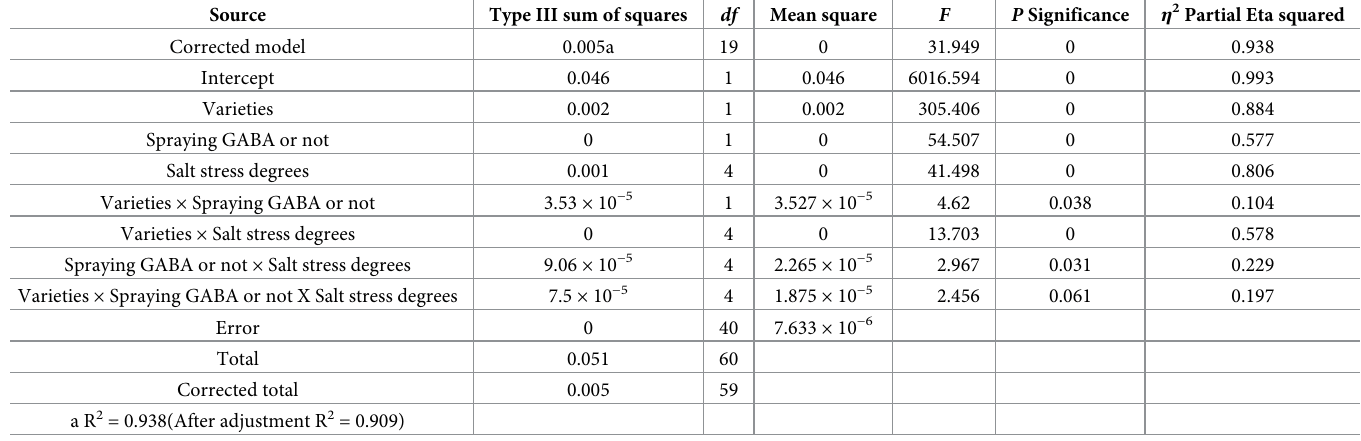
Table 3. Univariate multifactor analysis of variances of the root dry weight of rice seedlings.